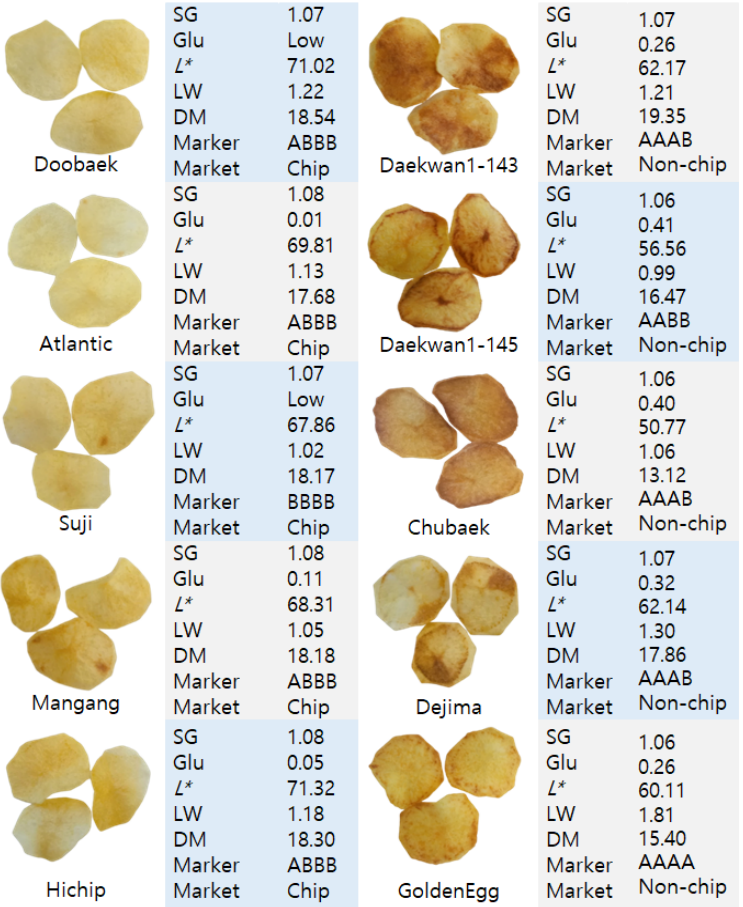
Figure 6. Results of genotyping of the HSI2-like gene harboring the two SNPs, c1_8019 ( a ) and c1_8020 ( b ) using the Kompetitive Allele Specific PCR (KASP) assay, as well as groupings of a panel of 84 potato clones. Scatter plots show clustering of potato clones on the X- (FAM) and Y- (HEX) axes. The black dots in the plots represent the NTC (non-template control). In terms of clear separations between the genotype groups, KASP_c1_8020 markers seemed better than KASP_c1_8019 because of the possibility of no spurious genotype calling. Please note that genotyping for the KASP_c1_8019 is called in reverse compared to that for the KASP_c1_8020.